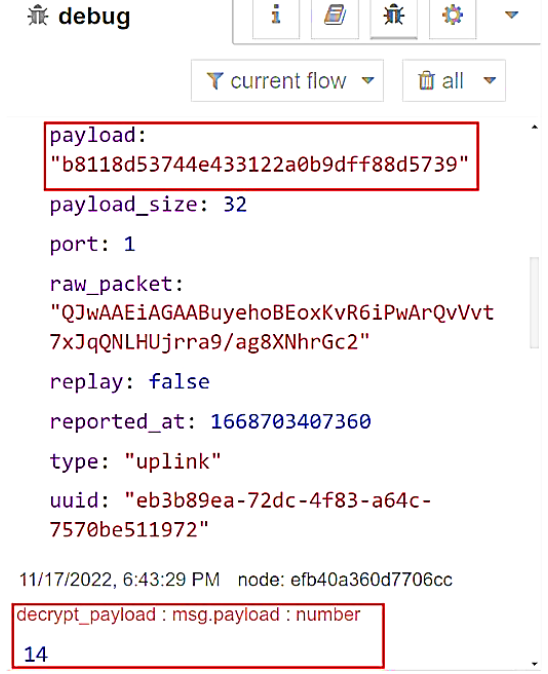
Figure 23. Received encrypted data.